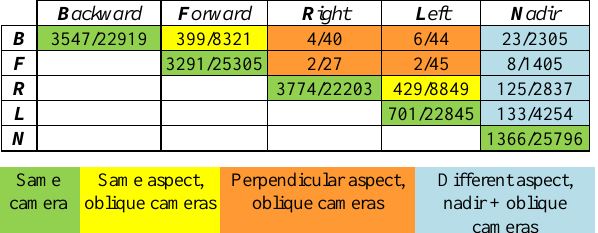
Table 2. Median / maximal number of matches between camera views.